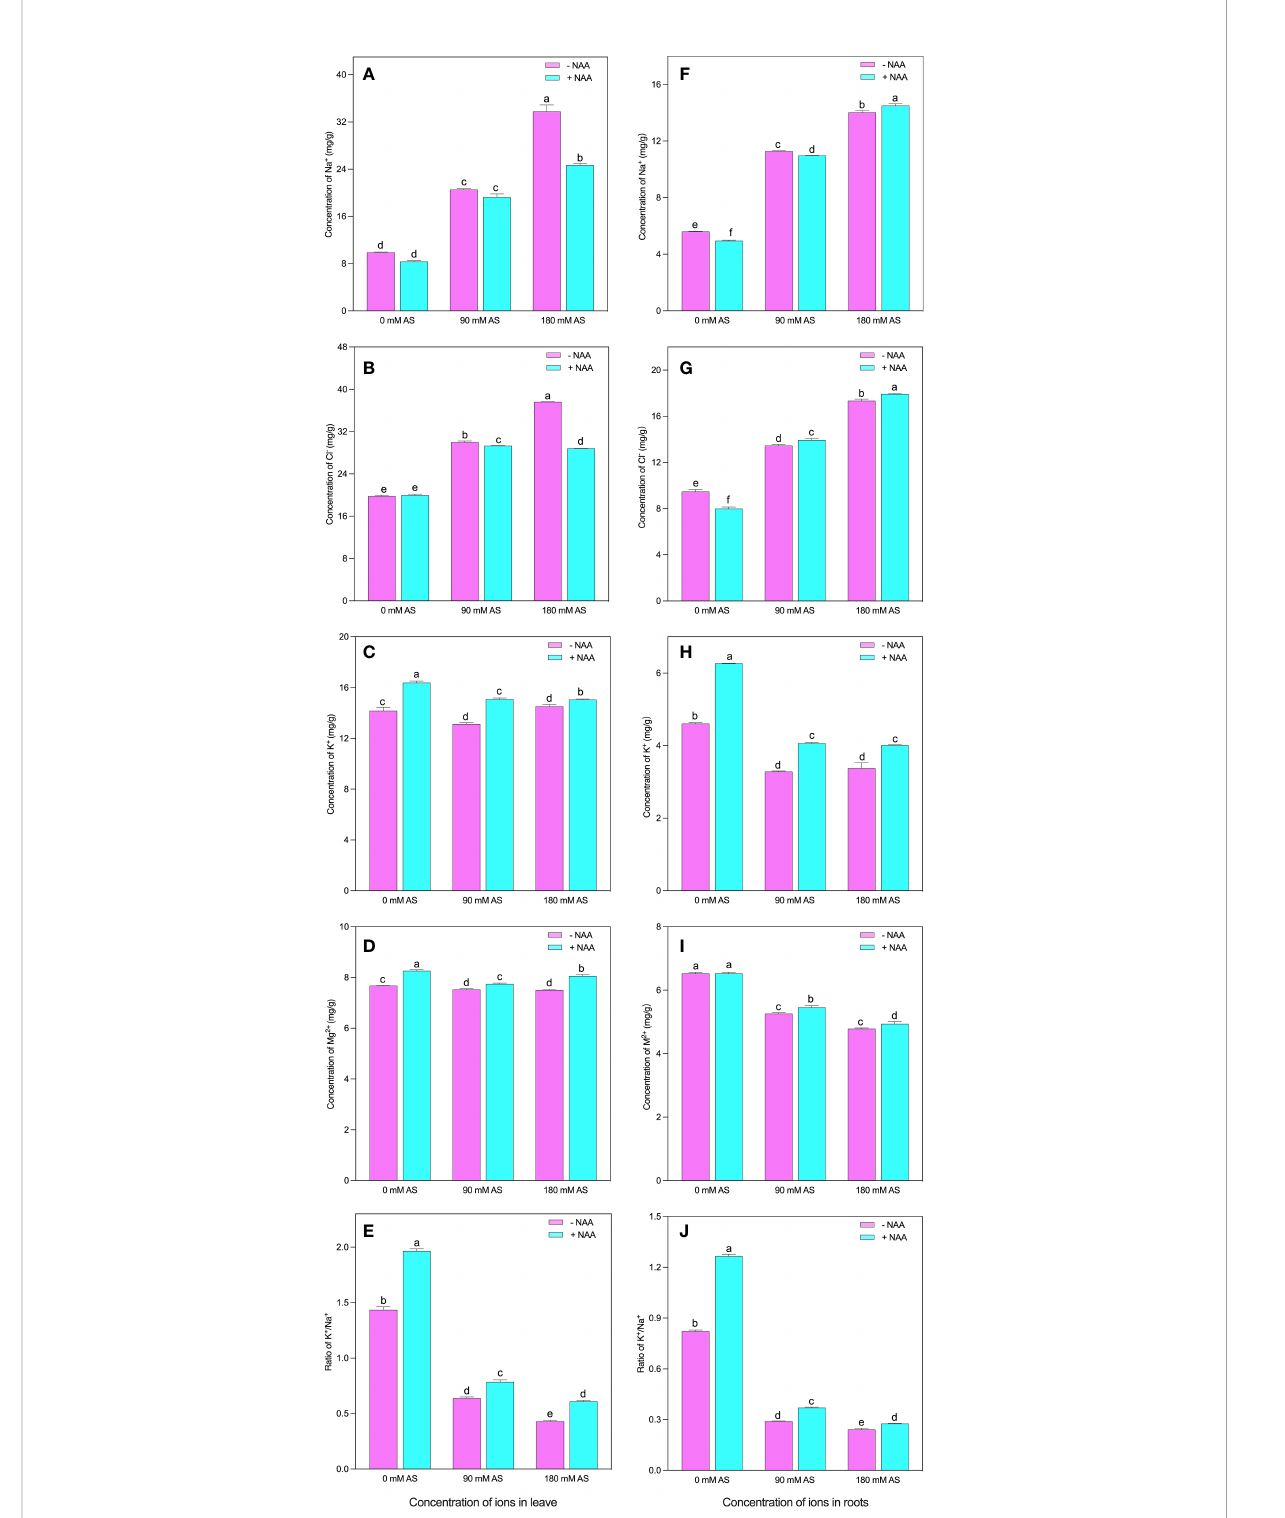
FIGURE 2 Changes in ions concentration of leaf (A) Na + , (B) Cl - (C) K + (D) Mg ++ and (E) K +/ Na + ratio and root (F) Na + , (G) Cl - (H) K + (I) Mg ++ and (J) K +/ Na + ratio of chufa plants under alkaline stress (AS) and exogenous naphthaleneacetic acid (NAA)application. Bars represents SD of mean, n=3. Different letters indicate signi fi cantly different values at P <0.05 (Duncan ’ s